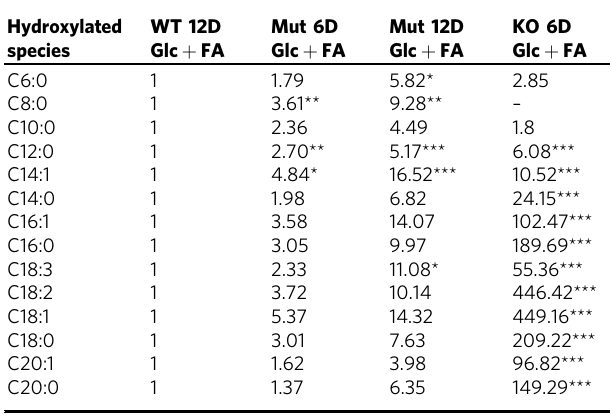
Table 1 Hydroxylated FA Species Fold-Change Abundance Compared to WT 12D Glc +